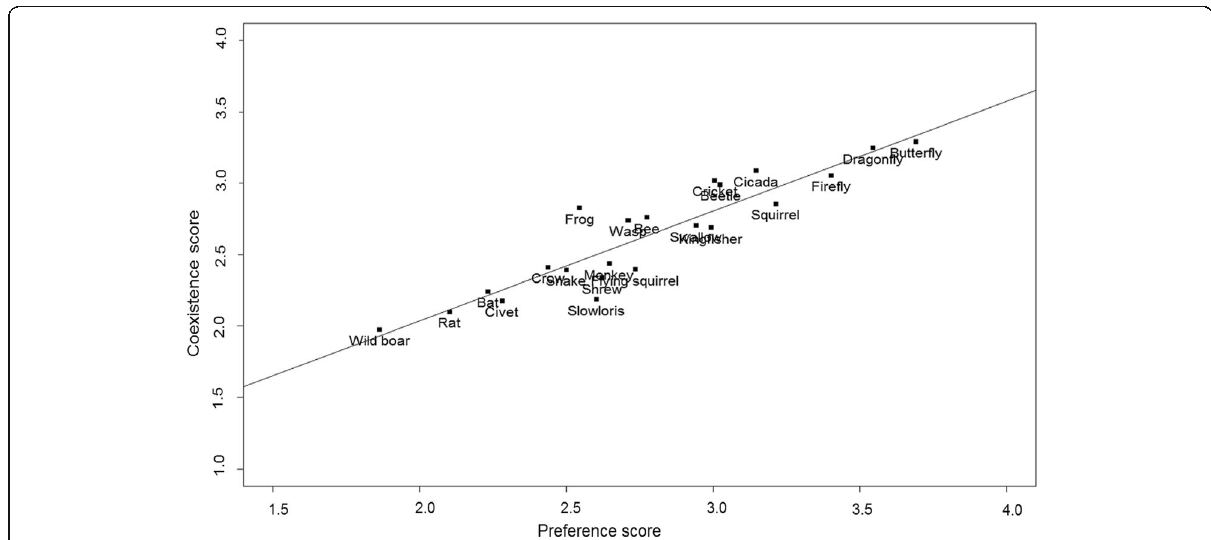
Fig. 1 Preference and Coexistence scores for the 22 wild animal species. Species classifications were based on Ward ’ s dendrogram of a hierarchical cluster analysis (clusters 1 – 3) (see also Fig.